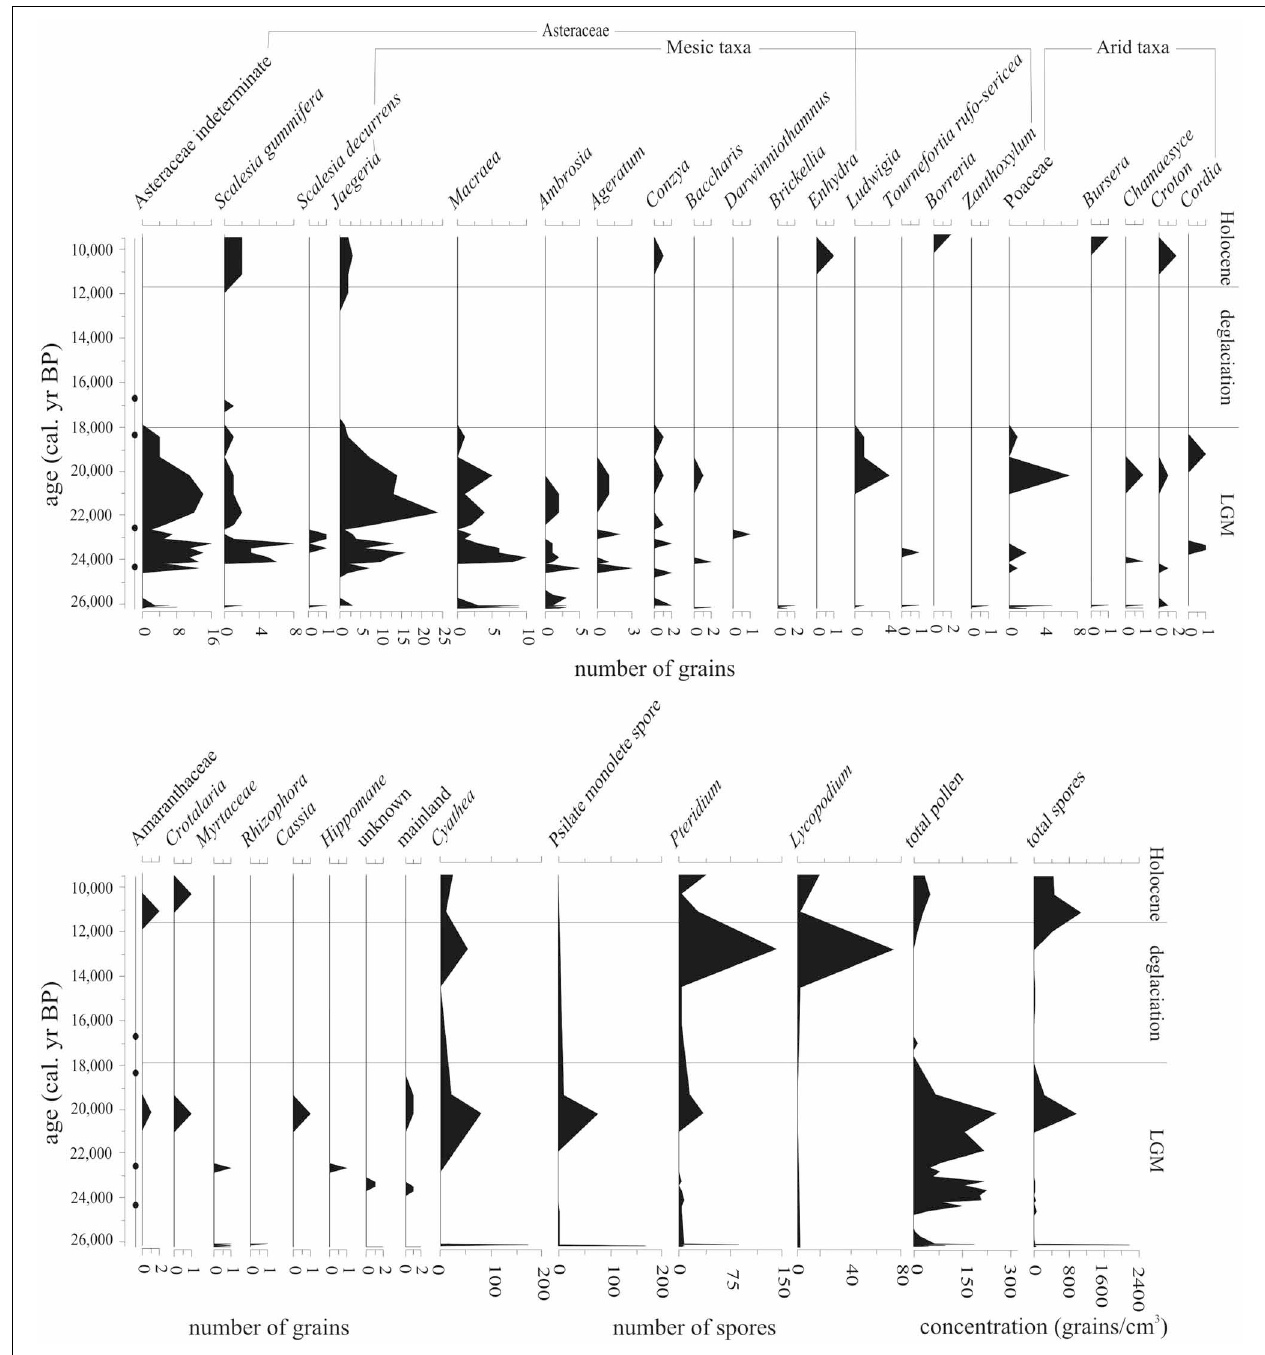
FIGURE 5 | Pollen and spore abundance (number of grains) of all taxa located within LGM/deglaciation-aged samples (26,200–9550 cal. year BP) from Paul’s Bog. Total pollen and spore concentrations were calculated as grains/cm 3 . Radiocarbon date locations (solid circles) on right of age axis.